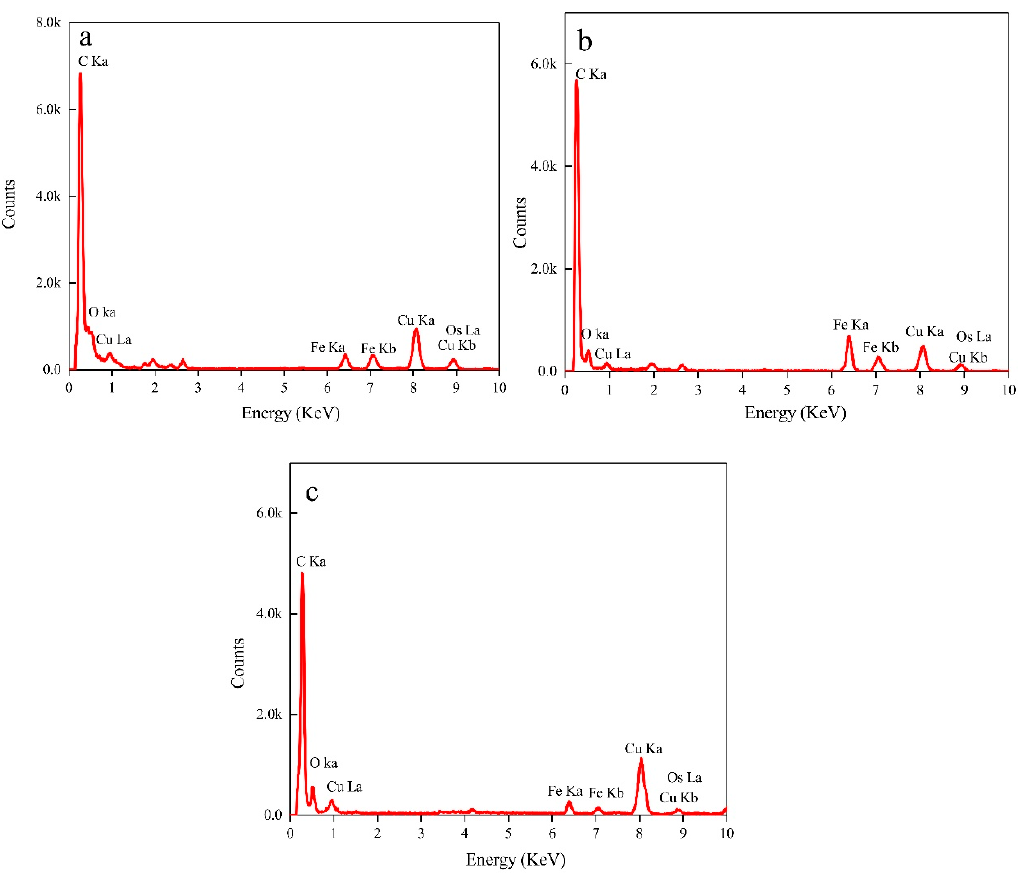
Figure 6. Energy dispersive X-ray spectroscopy (EDX) analysis of the nanoparticles synthesized by bacteria in media 1 # ( a ), 2 # ( b ), and 3 # ( c ).